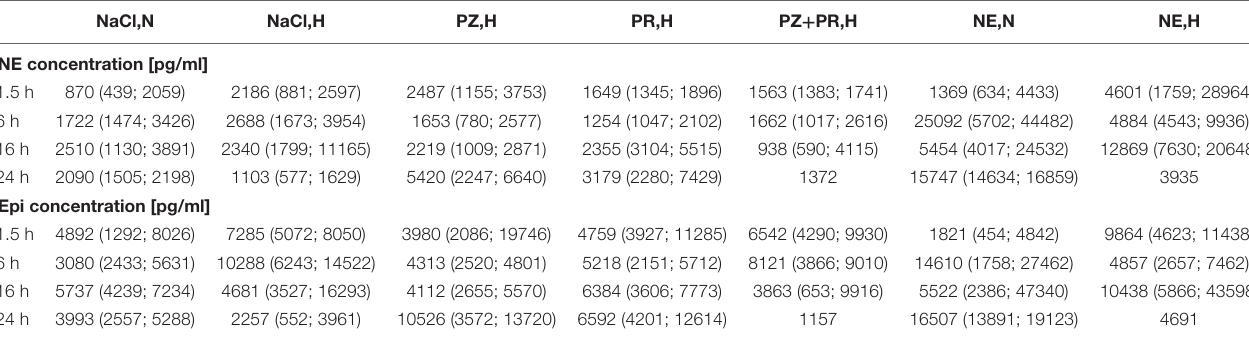
TABLE 4 | Effects of hypoxia and/or adrenergic and antiadrenergic treatment on the plasma concentration of norepinephrine (NE) and epinephrine